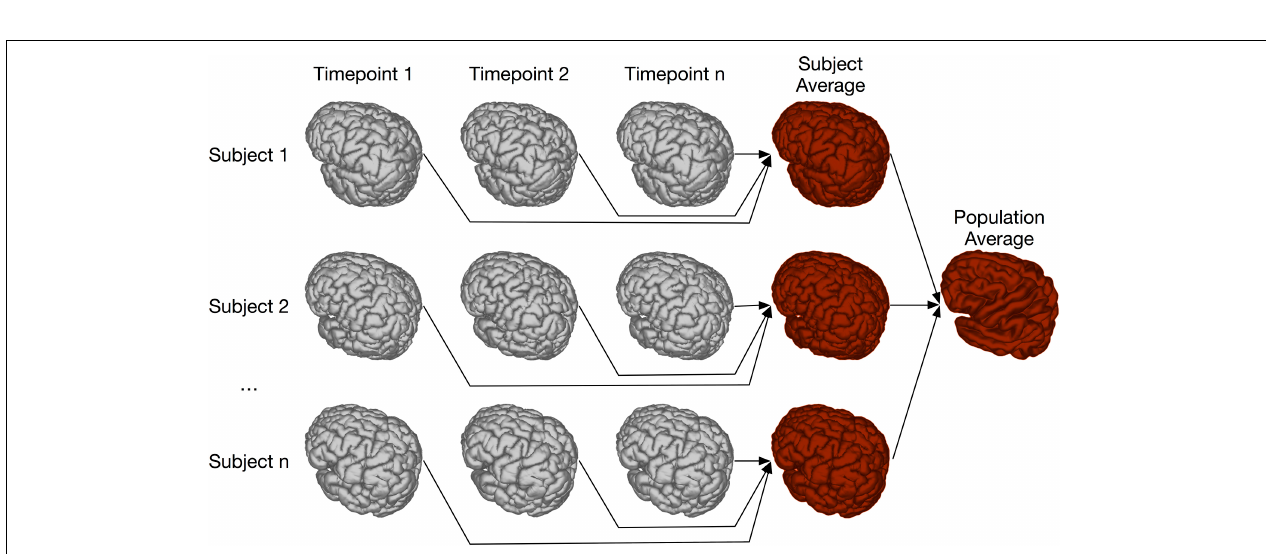
FIGURE 11 | Schematic of the two-level